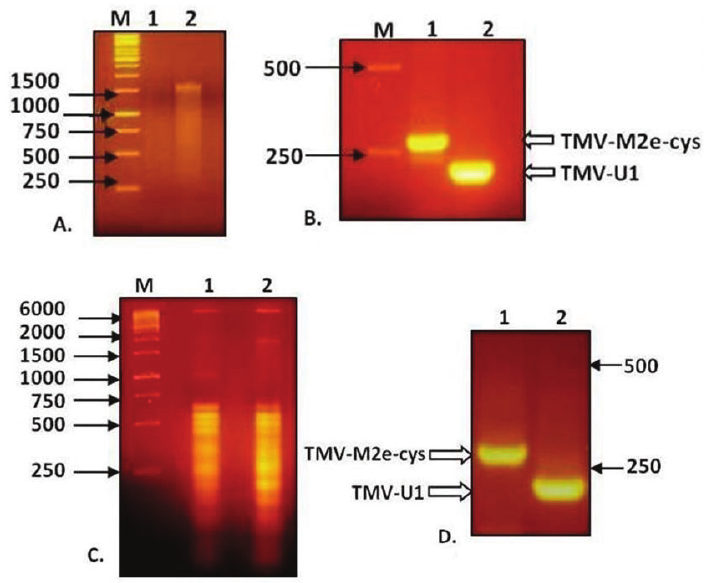
Figure 4. Analysis of RNA of TMV-M2e and RT-PCR products in 2% agarose gel. ( A ) RNA isolation from viral particles preparations. ( B ) Analysis of RT-PCR products derived from the genomic RNA of viral preparations. ( C ) Total RNA isolation from infected plant tissue. ( D ) Analysis of RT-PCR products derived from total RNA of